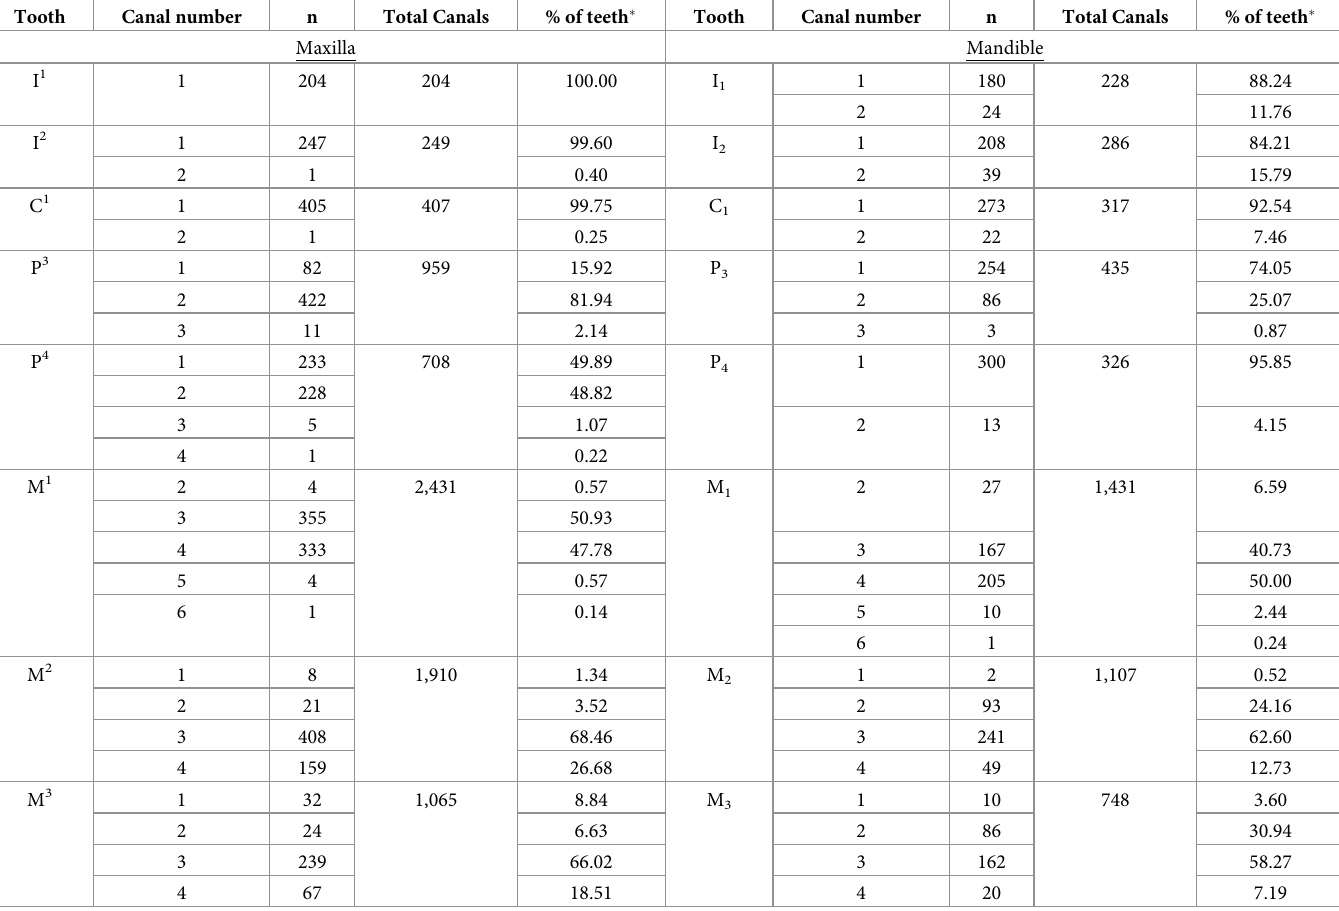
� From Table 2. Congenitally absent teeth not included in statistics for this